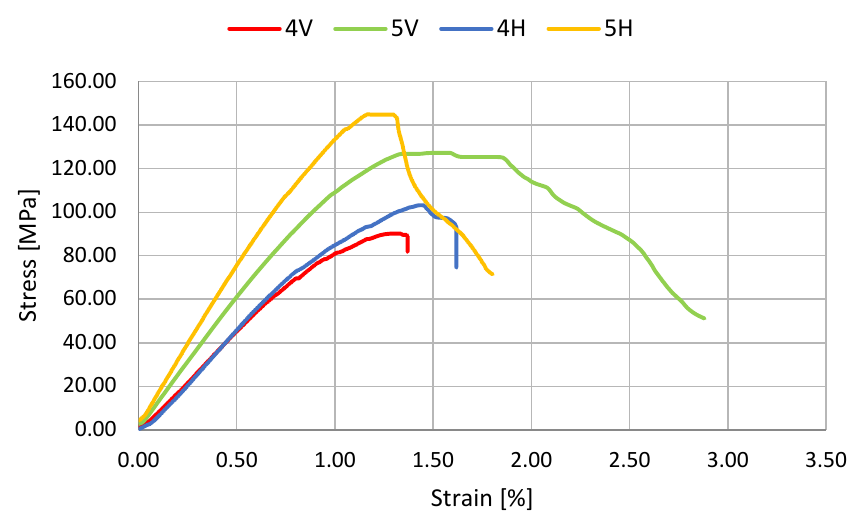
Figure 4. Representative curves for samples with 15 mm long carbon fibers.